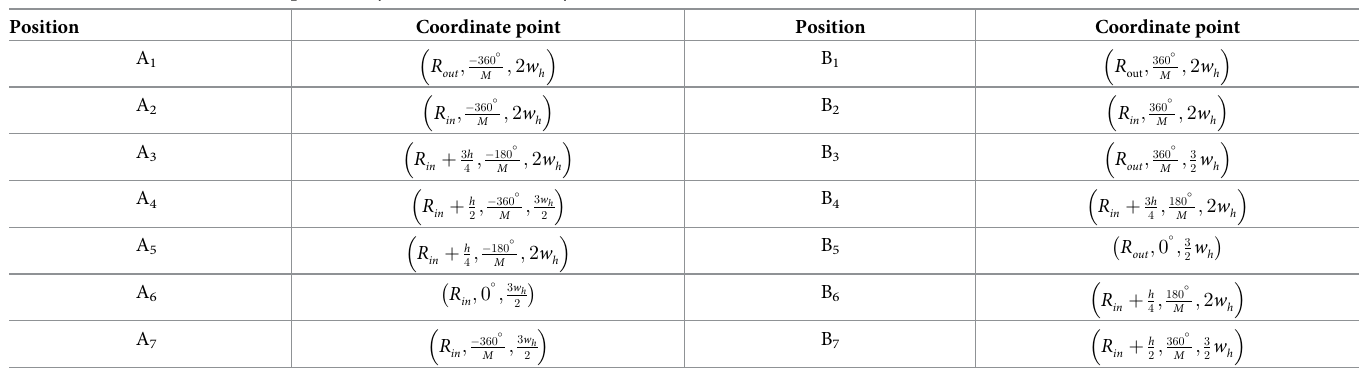
Table 1. Coordinates of A i and B i points in cylindrical coordinate system. Position